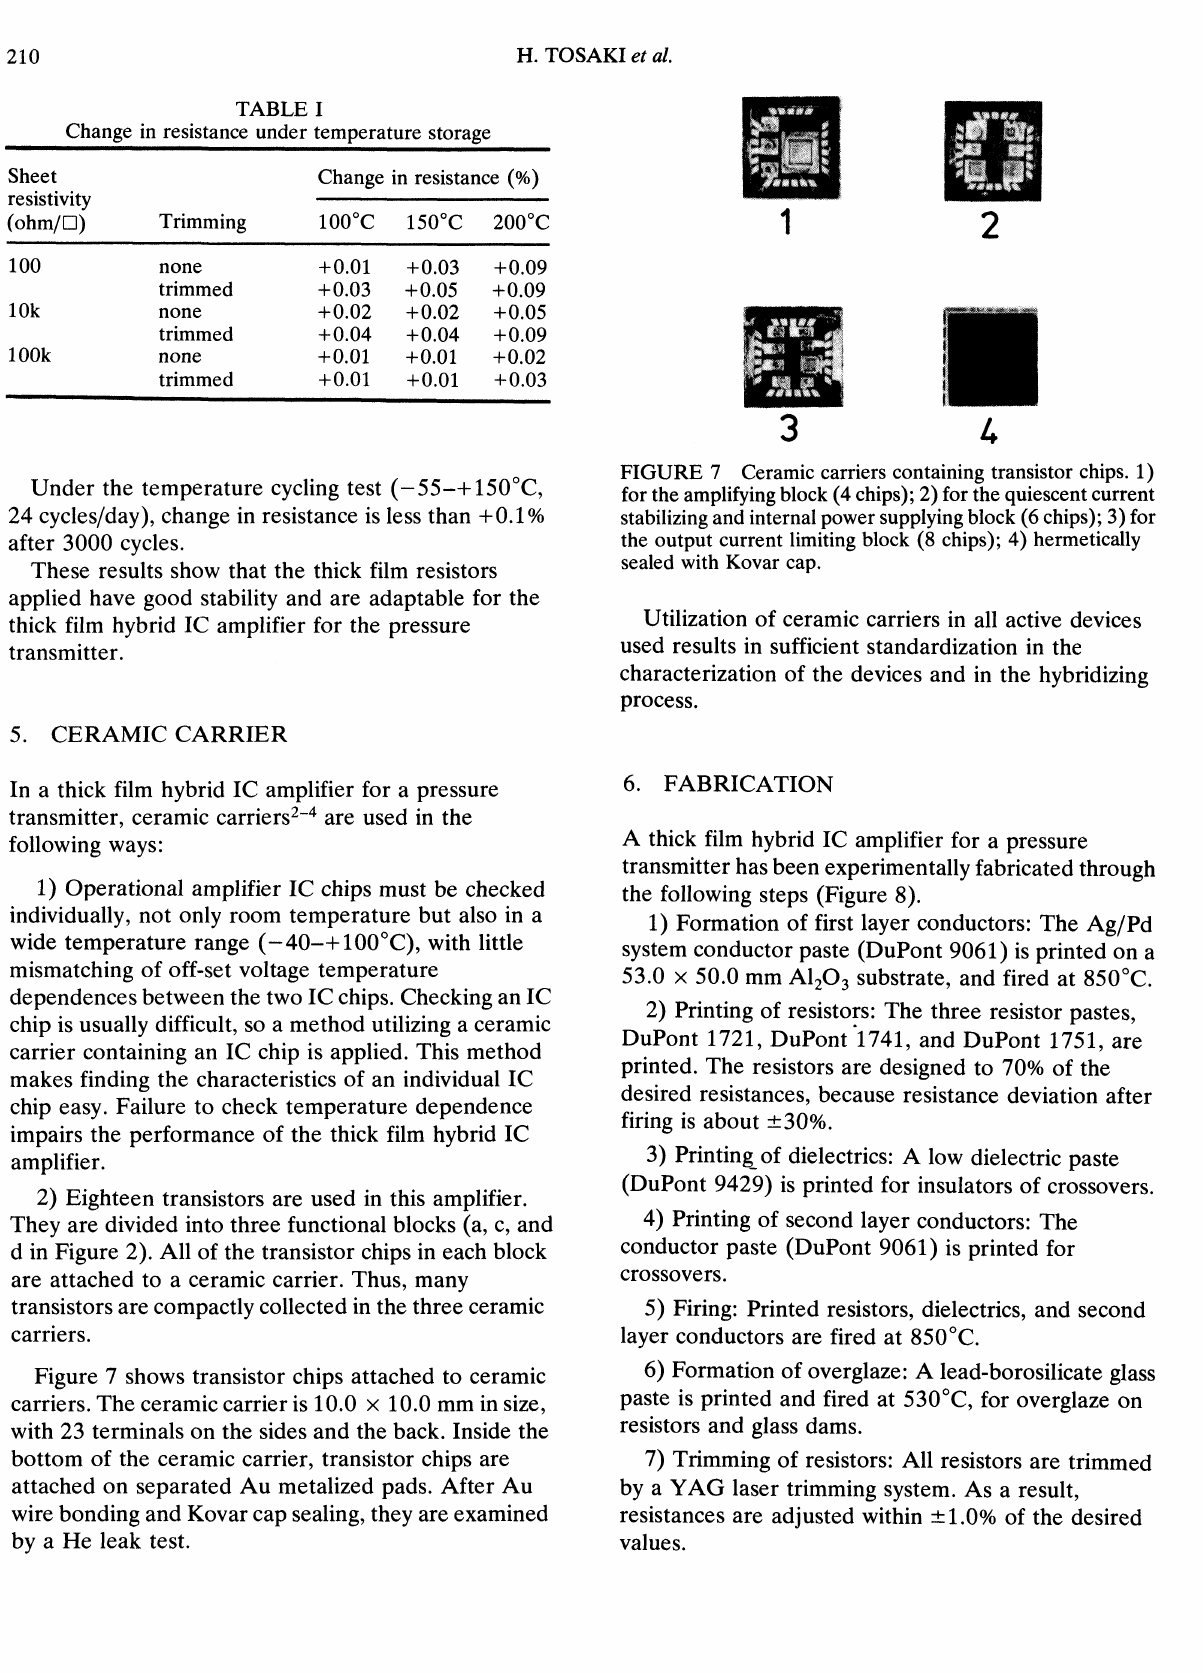
TABLE Change in resistance under temperature storage